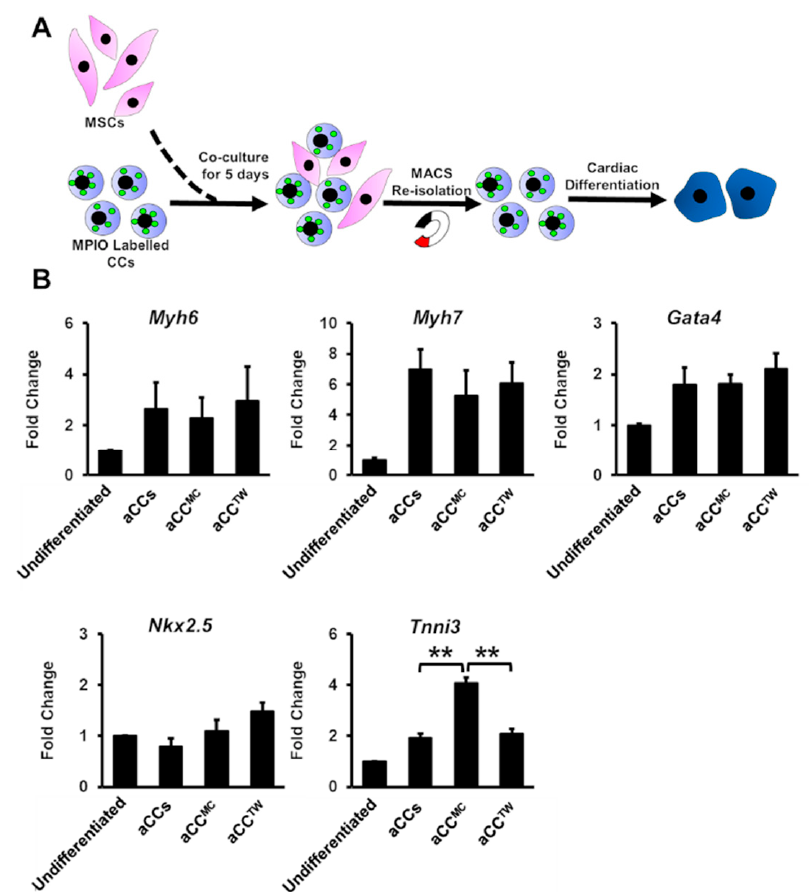
Figure 4. Co-culture with MSCs minimally improving the cardiomyocyte differentiation of aCCs. ( A ) Schematic diagram showing the cardiac differentiation of re-isolated CCs after co-culture. ( B ) Cardiac gene markers ( Myh6 , Myh7 , Gata4 , Nkx2.5 , and Tnni3 ) were performed by qPCR. All data are mean ± SEM. ** p < 0.01. ( n = 3).